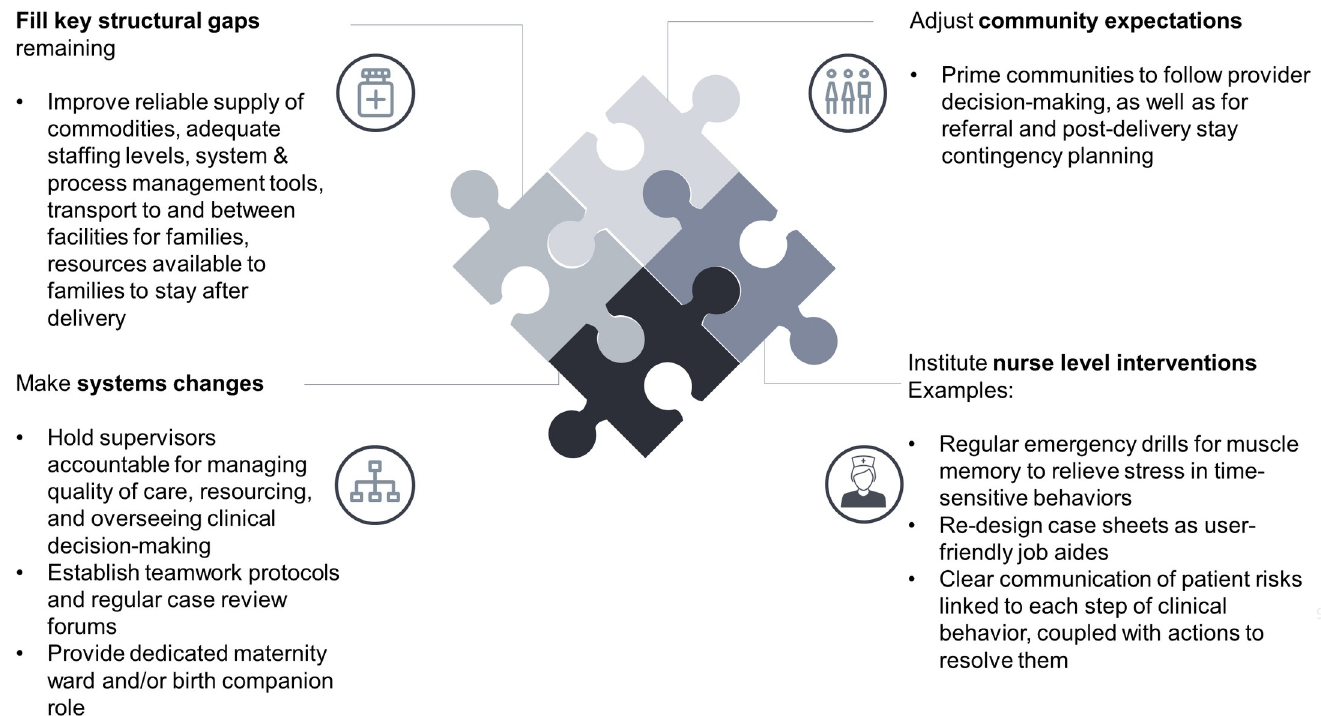
Fig 8. Summary of suggested recommendations and priorities to improve nurse quality of care within facilities.